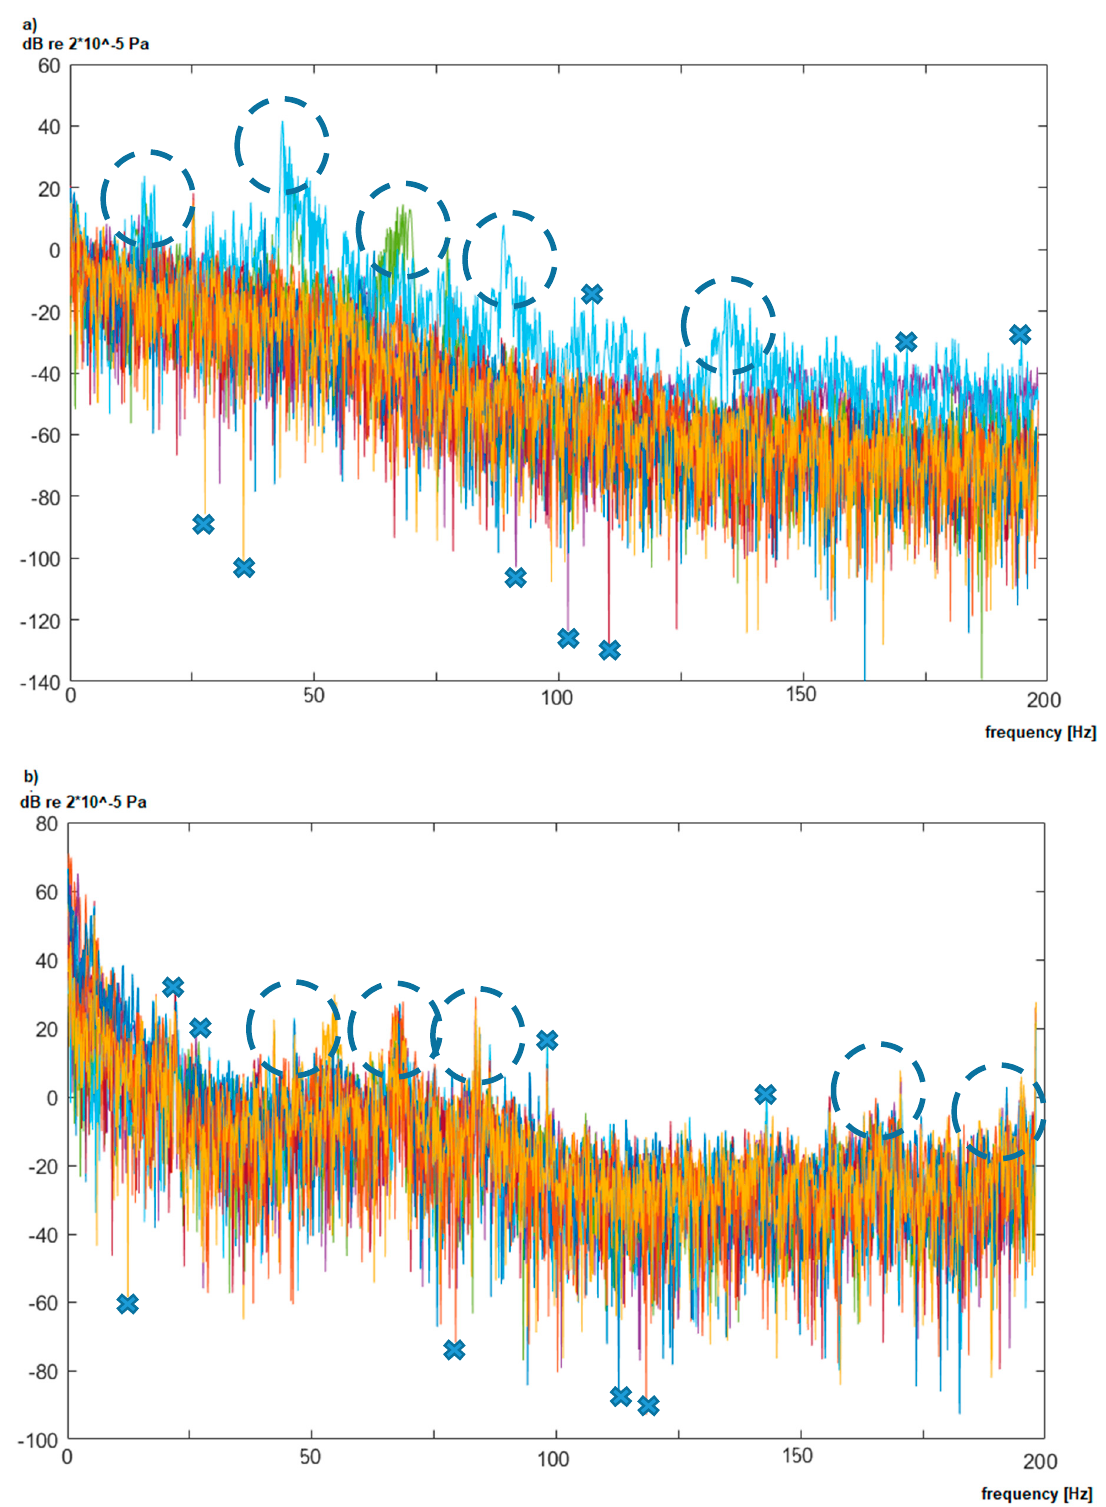
Figure 4. The example of spectra registered in the vicinity of: ( a ) transformer air-type, and ( b ) interior type.